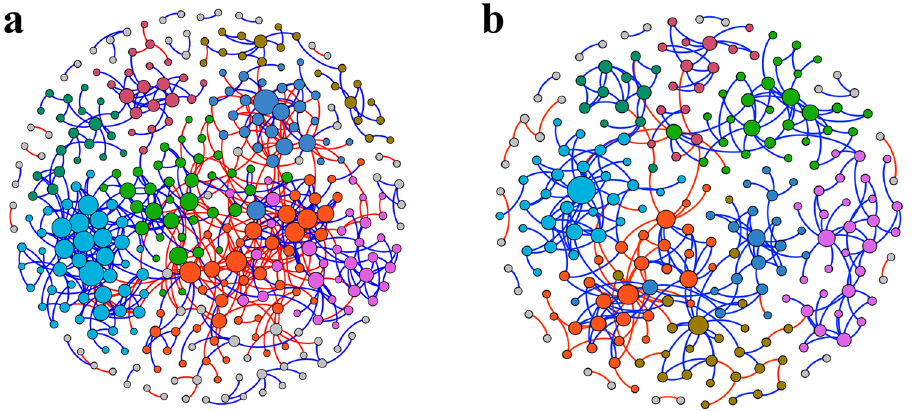
Figure 5. The co-occurrence ecological networks of marine bacterioplankton communities. ( a , b ) Phylogenetic molecular ecological networks (pMENs) depicting the bacterioplankton community interactions differences between control ( a ) and thermal discharge-impacted ( b ) areas. The node (OTUs) colour signifies the modularity class of the OTUs, and the node size is proportional to their connectivity values (node degree). Blue and red bridging edges represent positive and negative links, respectively among the nodes.